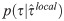
Conditional distributions of groundtruth tilt given the value of the tilt estimate.Each subplot shows the distribution of groundtruth tilt given a particular local estimate value p(τ|τ^local). For example, the fifth subplot in the first row shows the distribution of groundtruth tilts given that the local tilt estimate had a value of 120º (i.e., p(τ|τ^local=120°)). The fact that the conditional distributions of groundtruth tilt are approximately shift-invariant indicates that each local tilt estimate, regardless of its value, provides approximately equally reliable information about groundtruth tilt. Gray regions represent 95% confidence intervals from Monte Carlo simulations of 1000 experimental datasets. Confidence intervals at non-cardinal tilts (e.g., τ^local = 30º, 60º, 120º, 150º, etc.) are larger in part because the local model produces fewer non-cardinal tilt estimates, in keeping with the prior probability distribution over tilt, which has peaks at the cardinal tilts (e.g., τ = 0º, 90º, etc.; see Fig 2C).